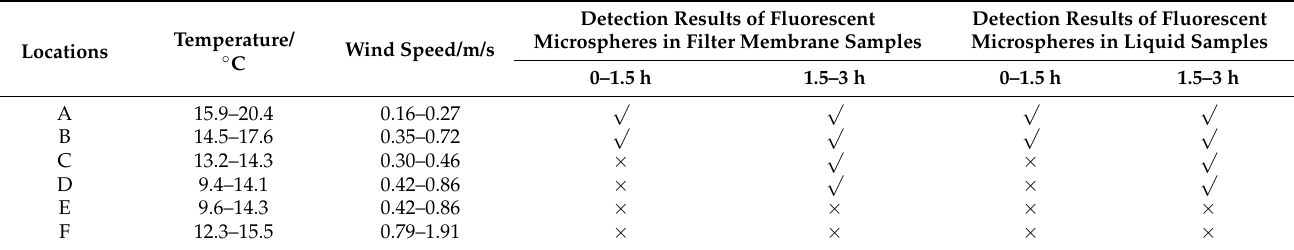
Table 1. Field monitoring and sample detection results at different